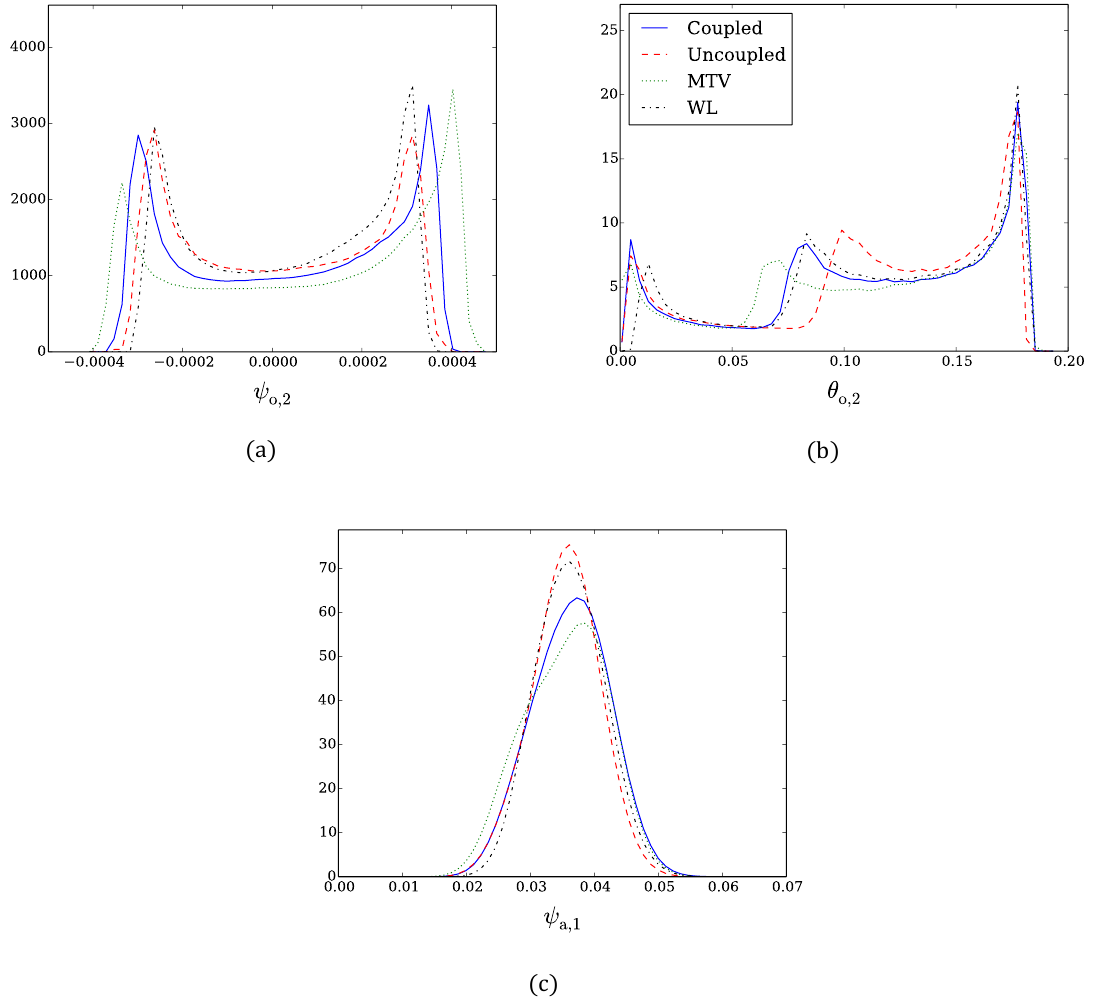
Figure 10. Probability density functions (PDFs) of the dominant variables of the system dynamics as in Fig. 2, but for the wavenumber 2 baroclinic parameterization and with the parameter set